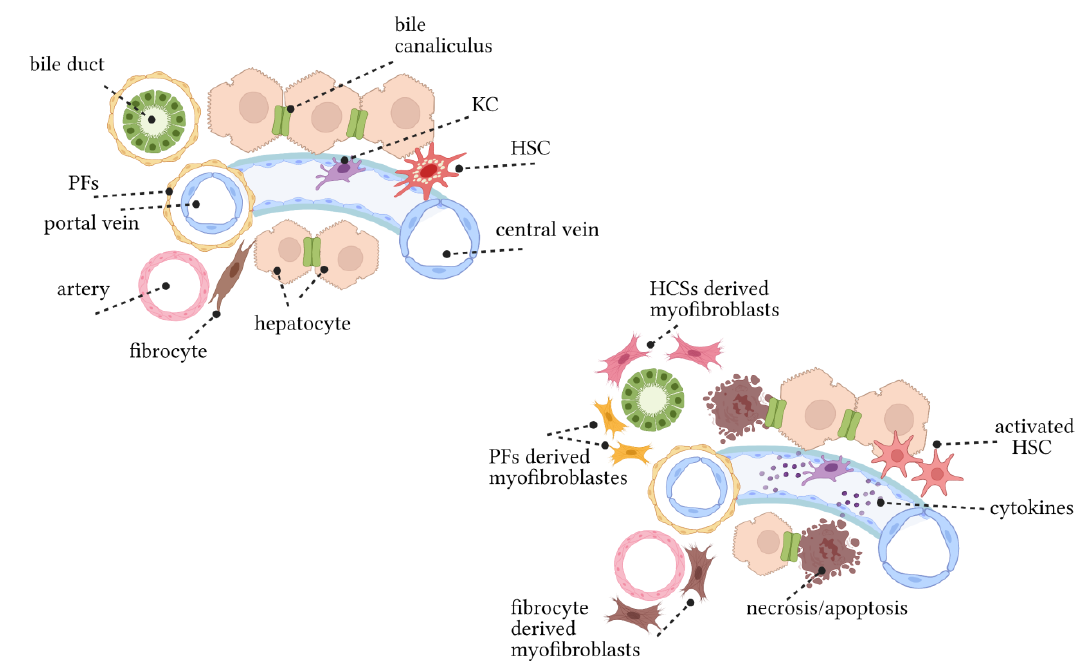
Figure 1. Pathogenesis of liver fibrosis. (1) The structure of liver lobules under physiological conditions. Biliary epithelial cells and hepatocytes, endothelial cells, HSCs, PFs, and KCs are the components of liver lobules. The bile duct, portal vein, and hepatic artery constitute the portal vein triad. HSCs are located in the space of Disse between hepatocytes and sinus- oidal endothelium. HSCs are considered to be hepatic pericytes which contain lipid droplets and are the main storage cells for vitamin A. KCs are the resident liver macrophages. Only a few fibrocytes exist in a healthy liver. (2) Changes in liver lobules caused by chronic liver injury. In response to chronic liver injury, hepatocytes undergo apoptosis and release factors that recruit KCs, BM macrophages, and fibroblasts to sites of hepatic damage. KCs, macrophages, and fibroblasts release TGFβ1, which is one of the most powerful profibrog enic cytokines that can activate HSCs into collagen I-expressing myofibroblasts (e.g., αSMA). HSCs and PFs deposit ECM and a small number of fibroblasts.